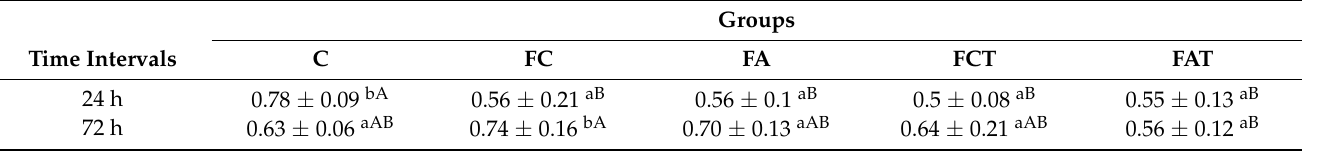
Table 1. Mean values and standard deviations of the cell viability results (570 nm optical density) of test groups within each time interval.